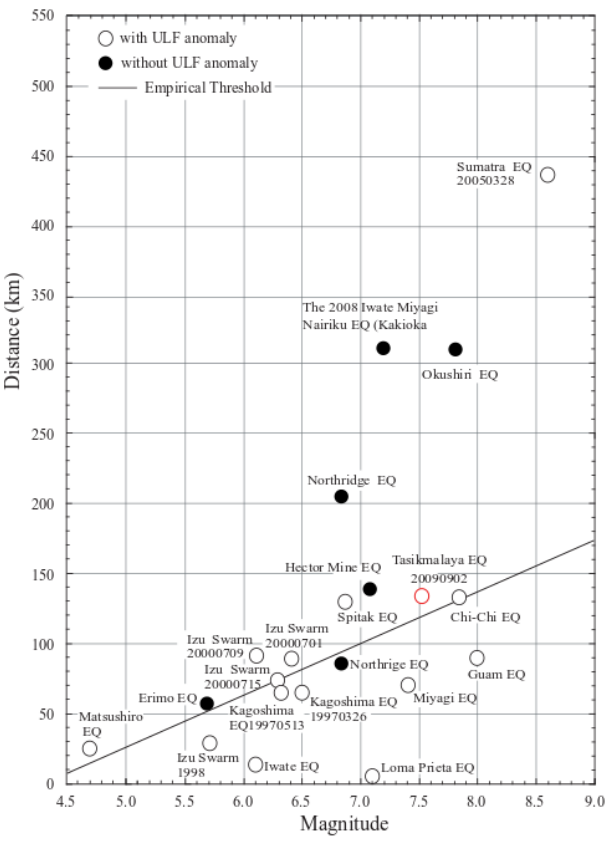
Fig. 10. The empirical relationship between magnitude and epicen- tral distance (after Hirano and Hattori, 2011). The Tasikmalaya EQ on 2 September 2009 is added with a red open